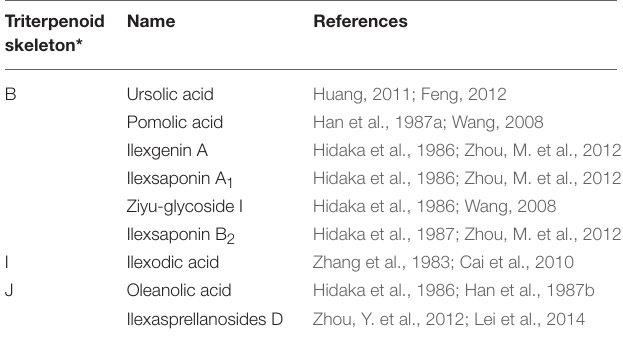
TABLE 1 | Common chemical constituents of I. pubescens and I.